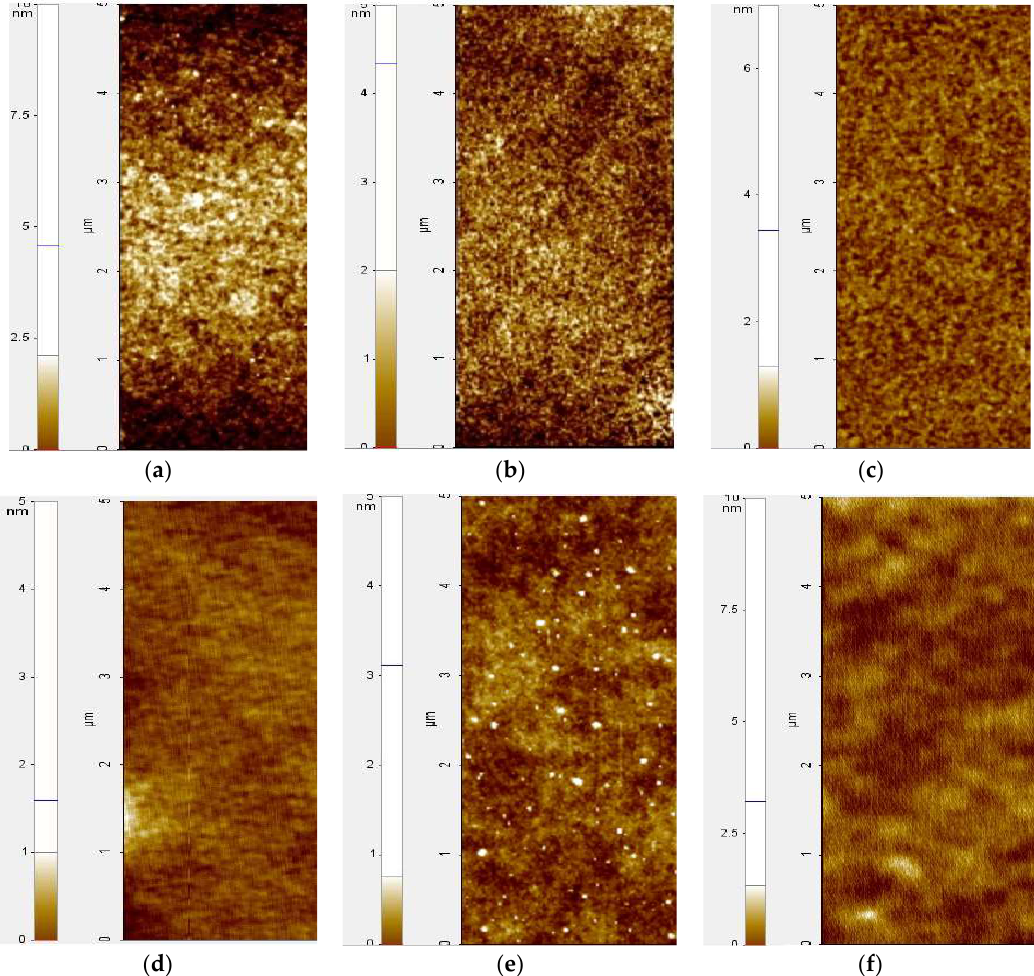
Figure 7. AFM images of the samples. ( a ) CB; ( b ) CB:DCE; ( c ) CB:AC; ( d ) CB:DMF; ( e ) CB:NMP; ( f ) CB:DMSO.